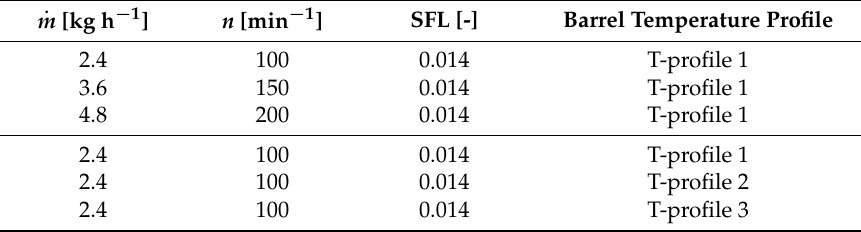
Table 1. Process parameters for the two different sets of extrusion